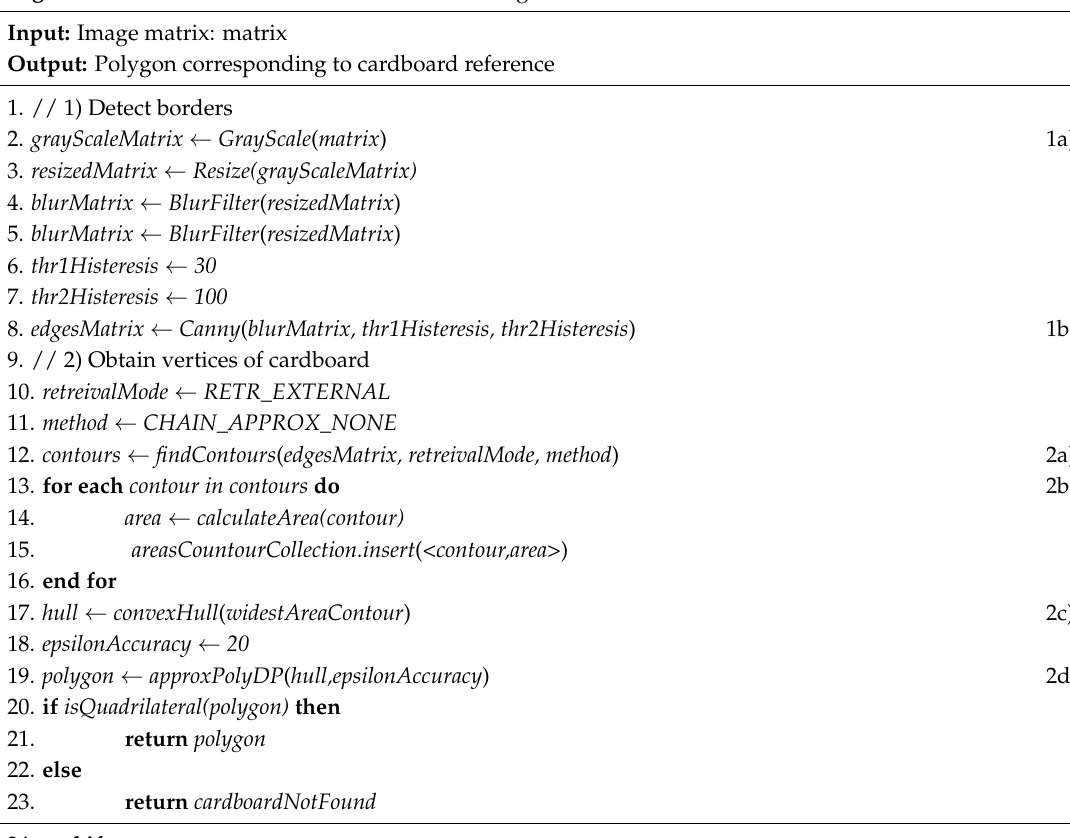
Algorithm 1. Pseudocode of cardboard detection